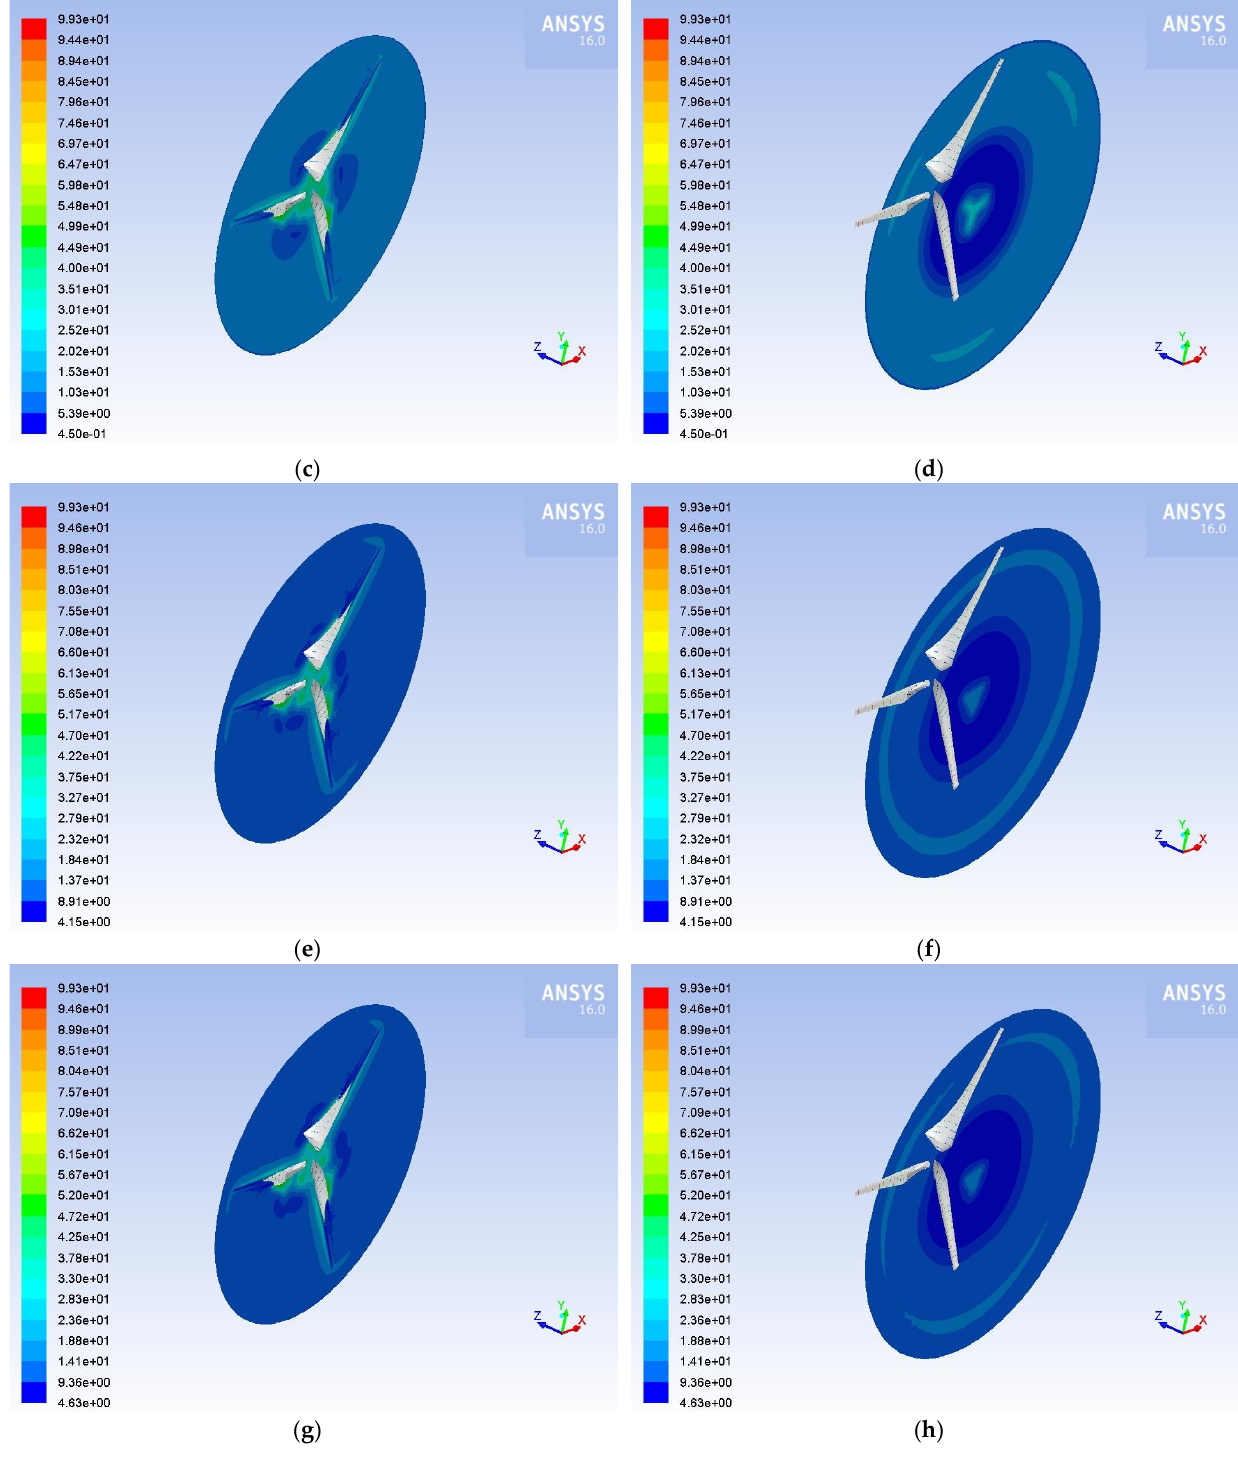
Figure 6. Velocity contours at wind speed of 15m·s − 1 : ( a ) 0 m from the rotor, Q = 0%; ( b ) 15 m from the rotor, Q = 0%; ( c ) 0 m from the rotor, Q = 1%; ( d ) 15 m from the rotor, Q = 1%; ( e ) 0 m from the rotor, Q = 5%; ( f ) 15 m from the rotor, Q = 5%; ( g ) 0 m from the rotor, Q = 10%; ( h ) 15 m from the rotor, Q = 10%.